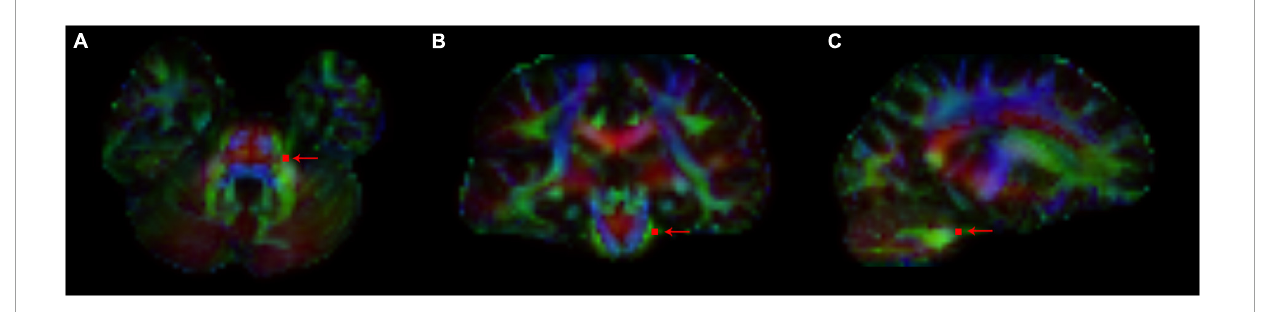
FIGURE1 The path of trigeminal nerve fiber bundles was reconstructed on the generated color direction map, and ROI points were depicted (arrow indicated) in REZ. FA, RD, AD, and MD values of trigeminal nerve corresponding to ROI points in each REZ region were measured. (A) Horizontal position; (B) coronal position; and (C) sagittal